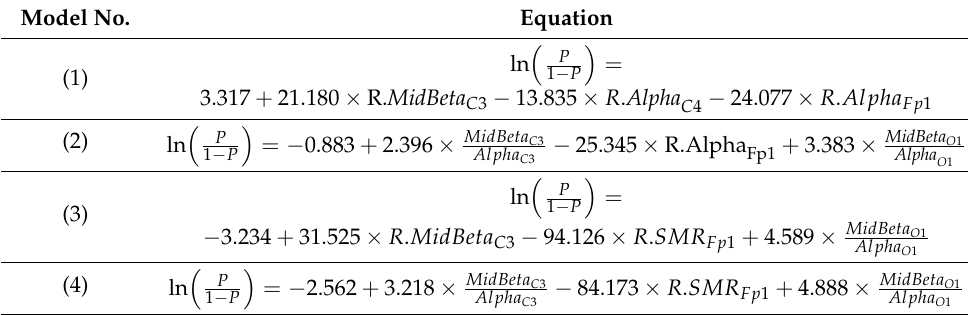
Table 8. Final logistic regression models. Model